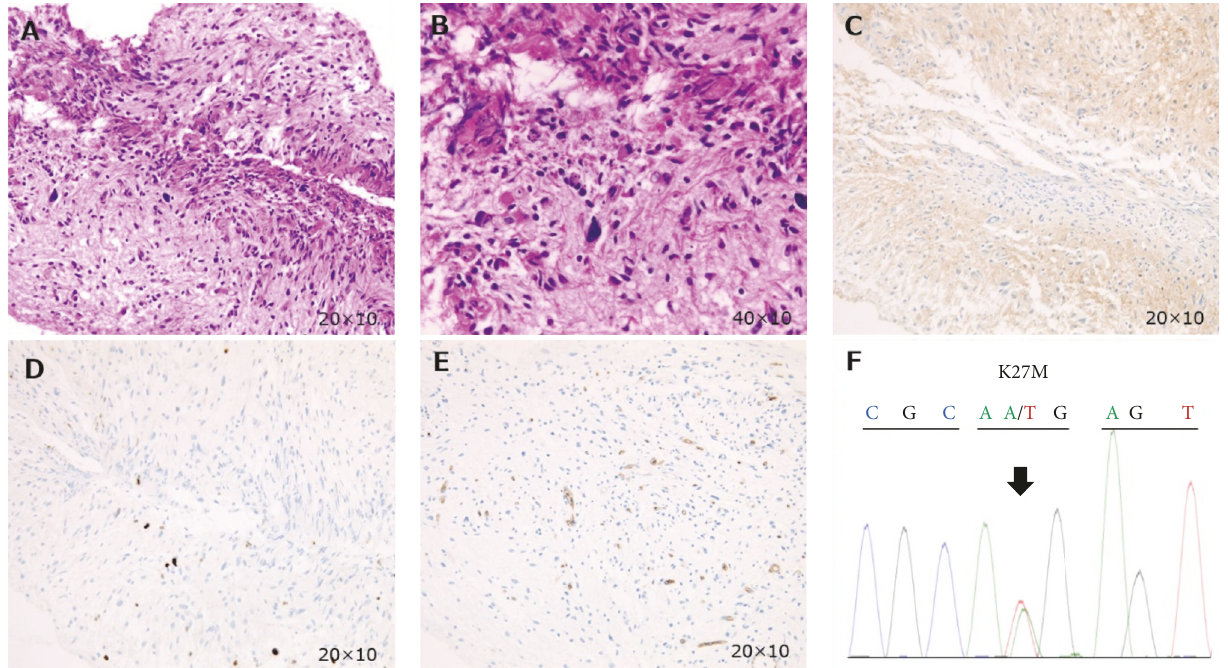
Figure 2: Hematoxylin-Eosin (H&E) staining revealed proliferation of various palisading cells with bipolar nature and no obvious findings of Rosenthal fiber (A, B). The immunohistochemical status of IDH1 showed wildtype IDH1 (C) and the Ki-67 labeling index was approximately 4% (D). CD34 staining suggested low microvascular proliferation (E). The optical magnification ratio of photomicrographs is 200-fold except for (B) (400-fold). The histone H3-K27M mutation was detected by Sanger sequencing (F).